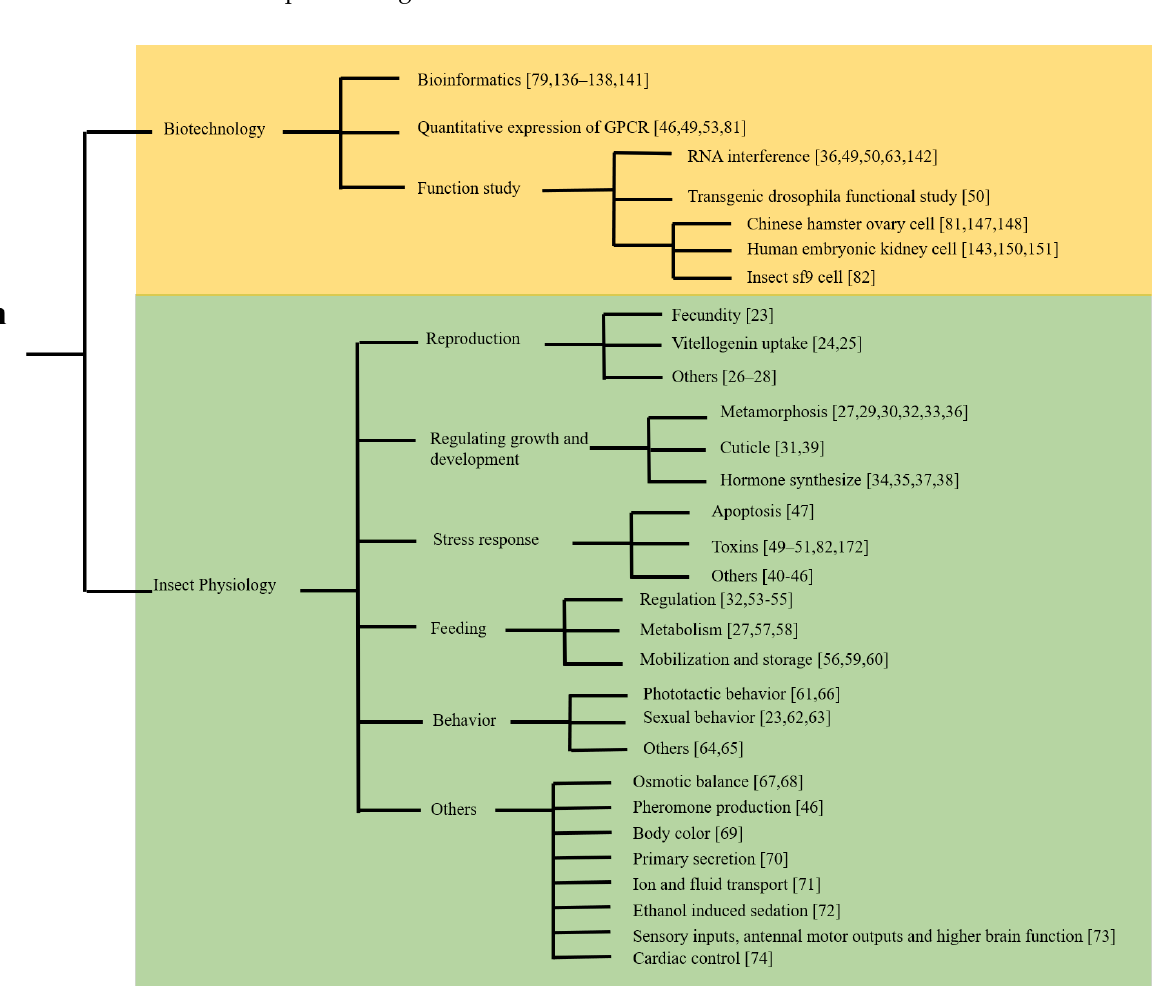
Figure 5. Graphical representation of the current status of GPCR research on insects and GPCRs and their regulatory pathways in insect physiology.